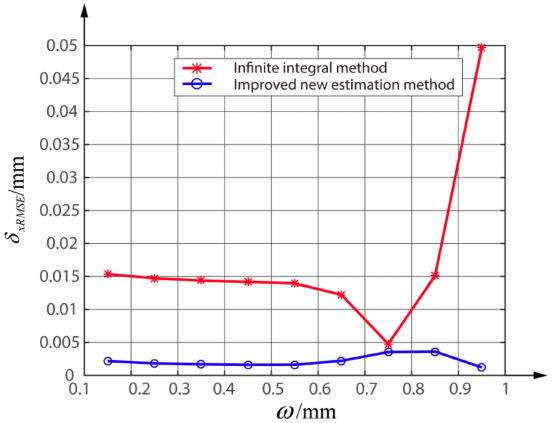
Figure 9. Comparison of the δ xRMSE between the improved new estimation method and the infinite integral method with different ω